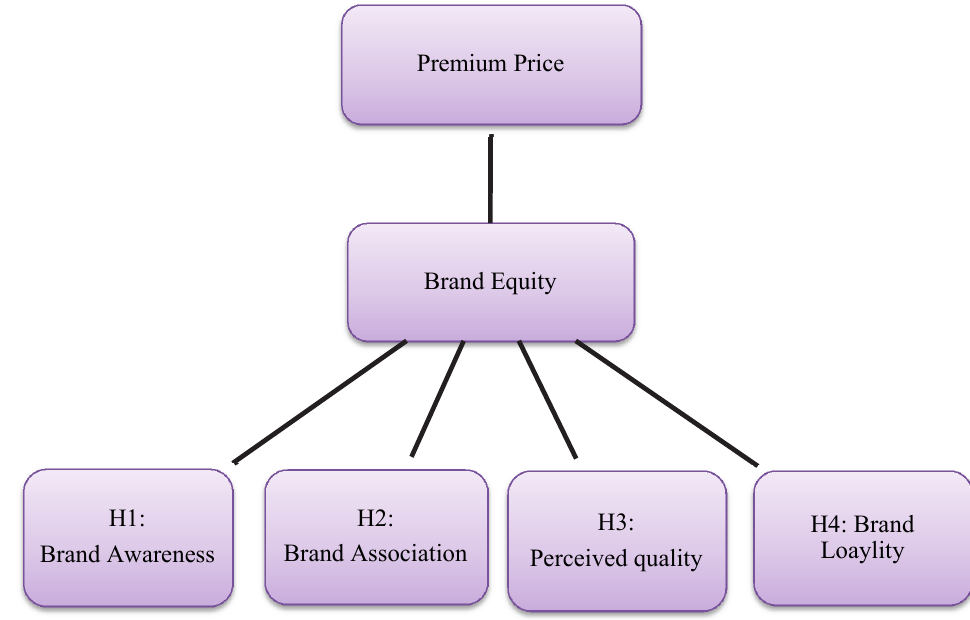
Fig. 2. Hypothetical Model of Brand Equity to Influence Customers to Pay Premium